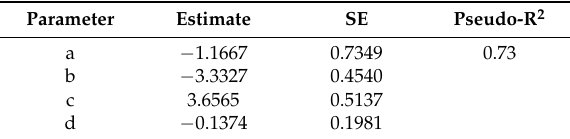
Figure 4. Observed percentage of bark fresh weight in relation to relative height ( left ) and to the predicted values ( right ). The three curves on the left-hand side from top down represent values estimated using Equation (3) for the minimum, mean and maximum DBHOB among the nine trees. The diagonal line on the right-hand side is the line of unity. Table 3. Estimated parameters, their standard errors (SE) and pseudo-R 2 of the percentage of bark fresh weight Equation (3) that was fitted using beta